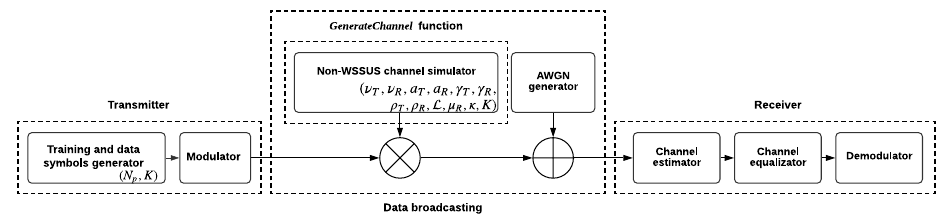
Figure 4. Block diagram for the simulation of a general V2X communication